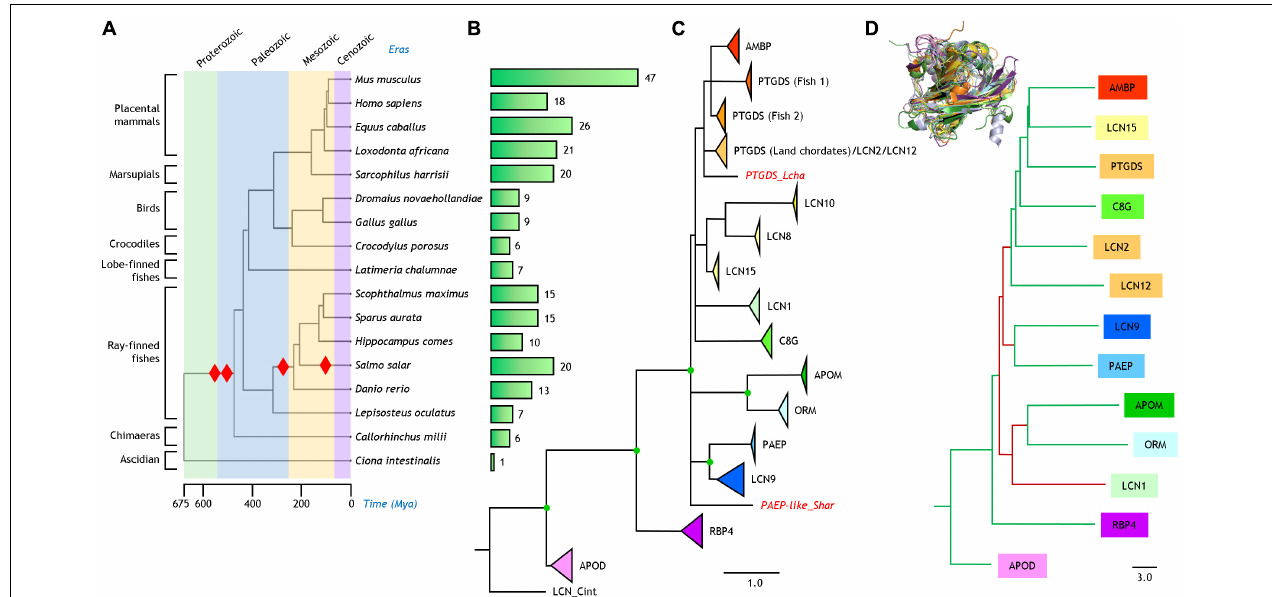
FIGURE 1 | Phylogenetic relationships of Lipocalins . (A) Phylogeny and evolution timescale of the organisms selected for our analysis. Red diamonds indicate whole genome duplications. (B) Bars depicting the number of bona fide Lipocalins found in each organism. (C) Phylogenetic tree of 250 Lipocalin protein sequences reconstructed from a structure-based multiple sequence alignment and a ML method. The tree was rooted with a tunicate Lipocalin (LCN_Cint) considered as outgroup. Unsupported nodes (bootstrap < 65%) are excluded and branches joined as a polytomy. Lipocalin monophyletic clades (bootstrap > 85%) are shown collapsed and color-coded. Scale branch length represents number of amino acid substitutions per site. Individual Lipocalins with unsupported groupings are shown in red and italics. Green dots point to full bootstrap support. (D) Dendrogram depicting the relationships of thirteen human Lipocalins structurally aligned (3D superimposition shown as an inset). Scale branch length represents distances obtained from the DALI similarity matrix. Branches in green and maroon point to relationships concordant or discordant, respectively, with the protein sequence-based phylogeny in (C)